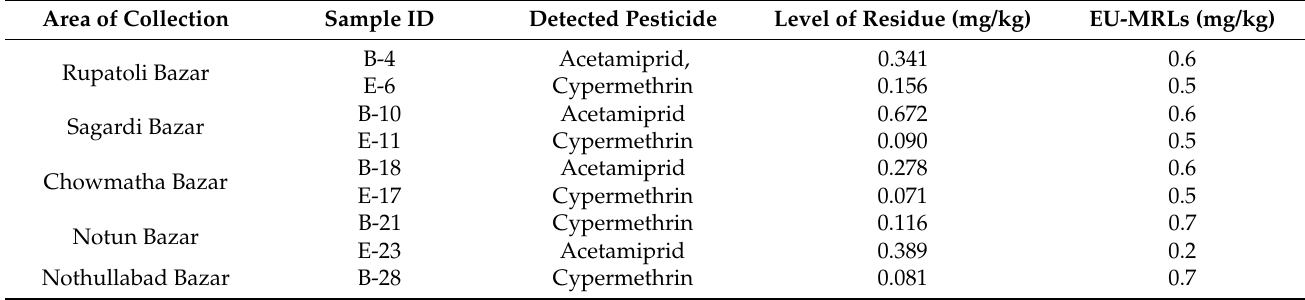
Table 1. The level of residues (mg/kg) of different pesticides found in the analyzed country bean (B) and eggplant (E) samples ( n = 60); six samples ( n = 6) of each vegetable collected from every